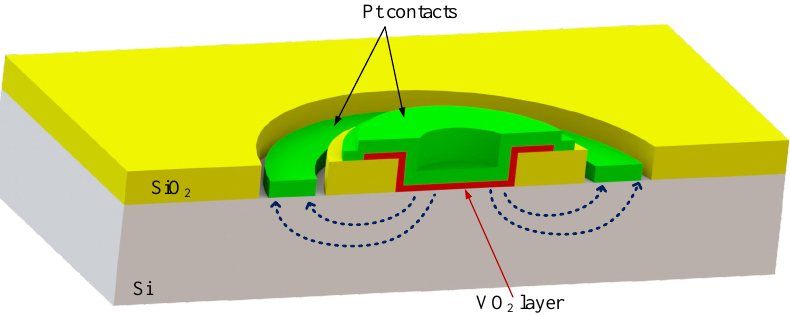
Figure 3. Cross-sectional view of the vertical VO 2 structure prepared in the